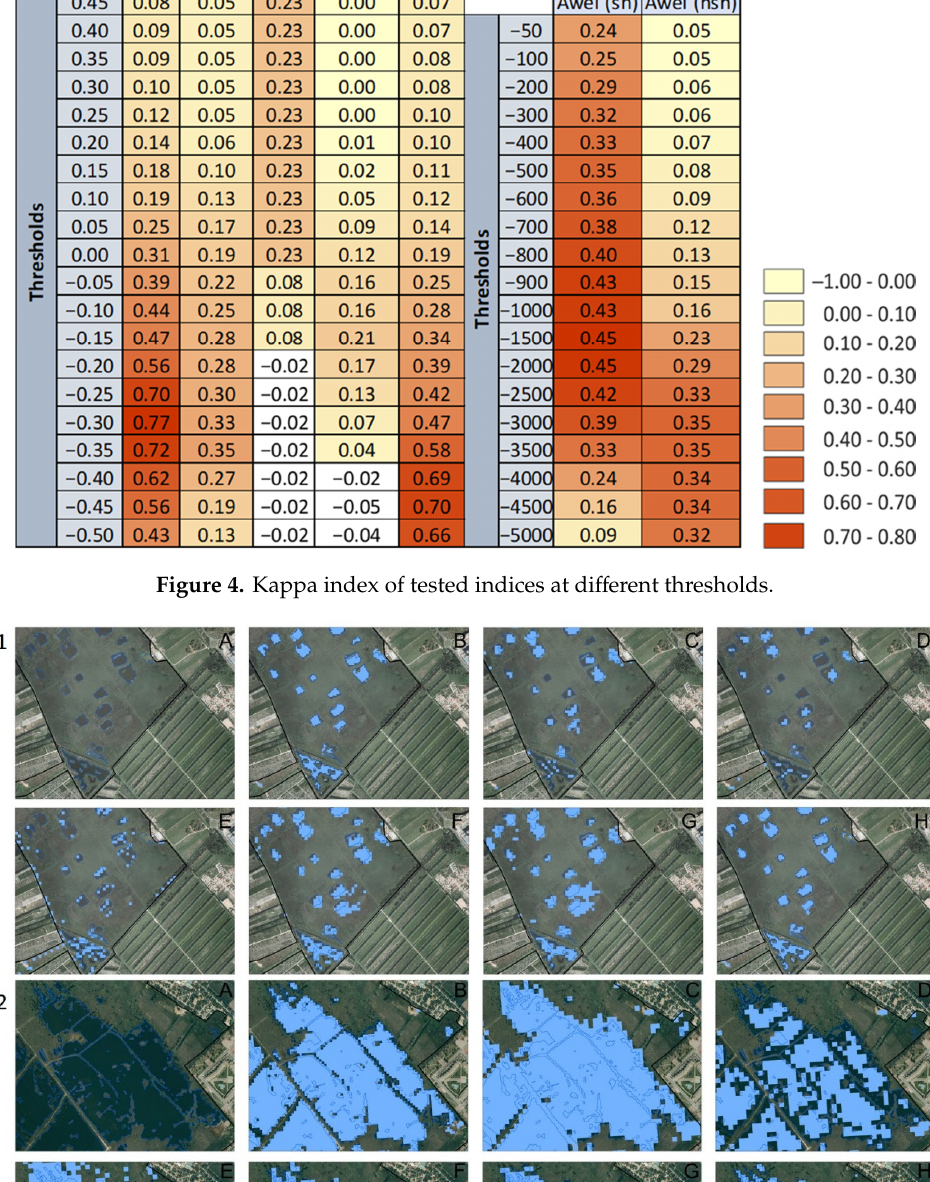
Figure 6. Overall accuracy of NDWI index tested at four studies areas and 3 years for the threshold range ( − 0.50 to 0.50).